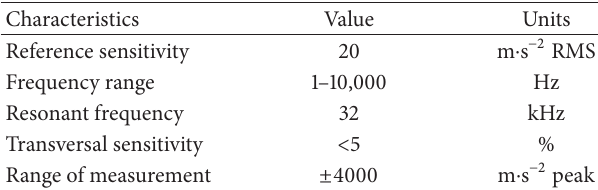
Table 1: Acceleration sensors parameters